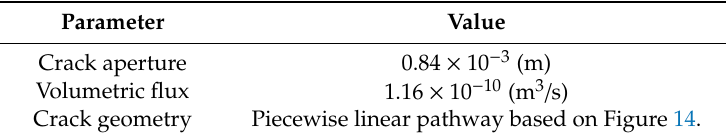
Table 4. Summary of crack parameters passed to GARFIELD-CHEM following the DEAFRAP and FEMWATER analysis.